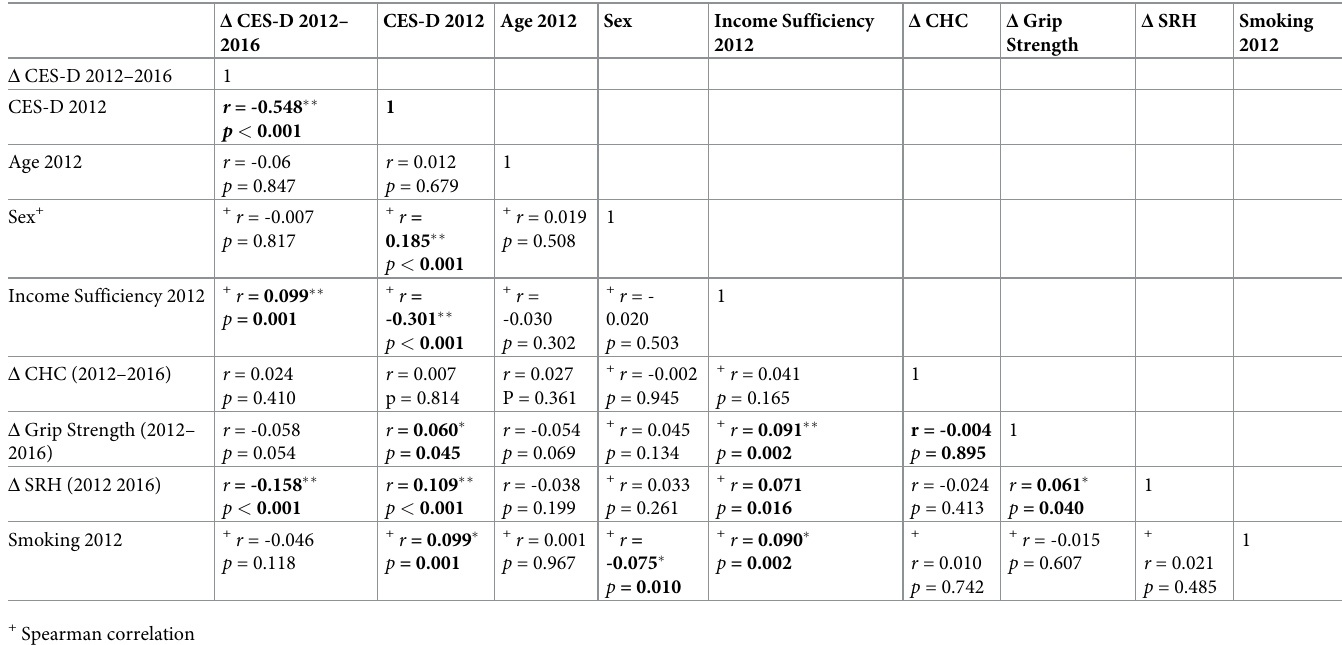
Table 3. Bivariate correlations of study